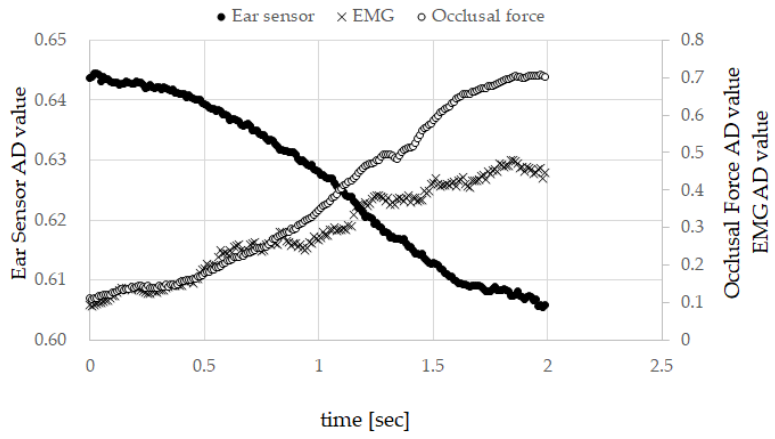
Figure 4. Measured results for subject A. The graph shows the measured results for which the correlation coefficient between the ear sensor value and the occlusal force was the highest among the six runs of subject A.